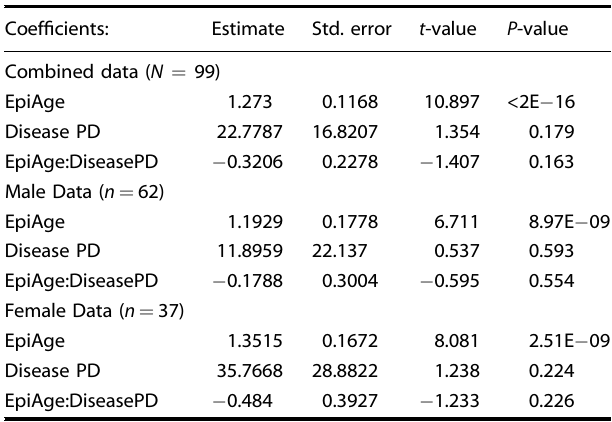
Table 3. Epigenetic clock linear regression results.